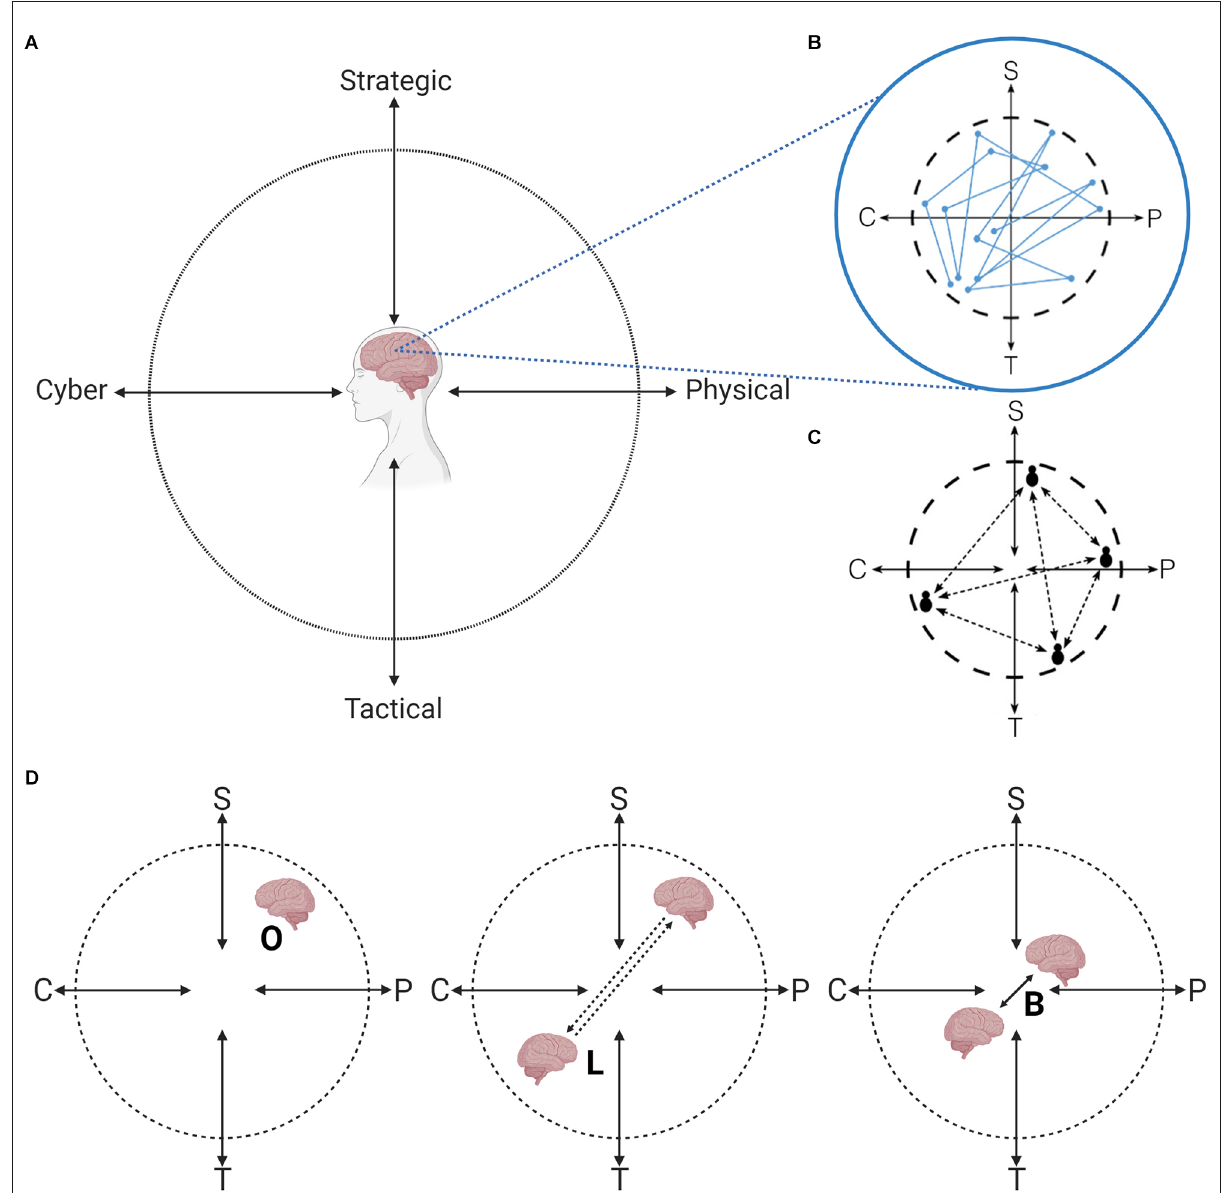
FIGURE2 The Hybrid Space (HS) framework and the OLB model. (A) The Hybrid Space (HS; Jøsok et al., 2016). (B) Self-location and movement in the HS require metacognition and self-regulation (Knox et al., 2017, 2019; Jøsok et al., 2019). (C) Communication between individuals located in different quadrants of the HS. (D) The OLB model. S, Strategic; P, Physical; T, Tactical; C, Cyber; OLB, Orient, Locate, Bridge. Figure adapted from Jøsok et al. (2016) and Ask et al. (2021b, 2022). Created with